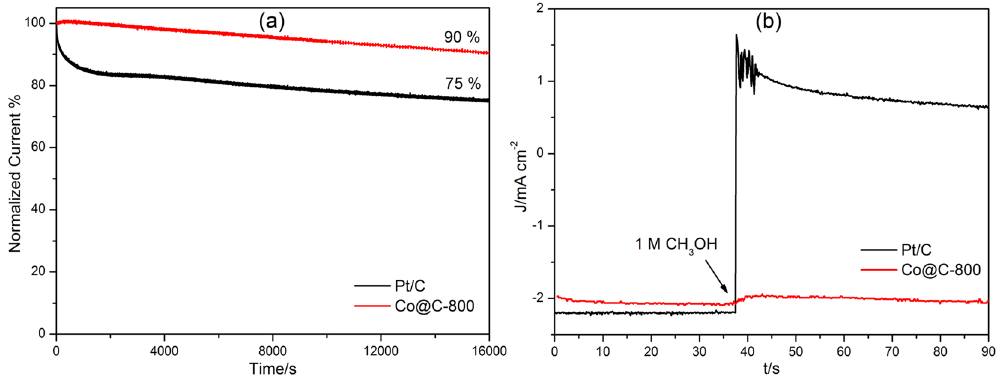
Figure 6. ( a ) Chronoamperometric responses at a 0.8 V constant potential, ( b ) Chronoamperometric responses at 0.8 V followed by the addition of